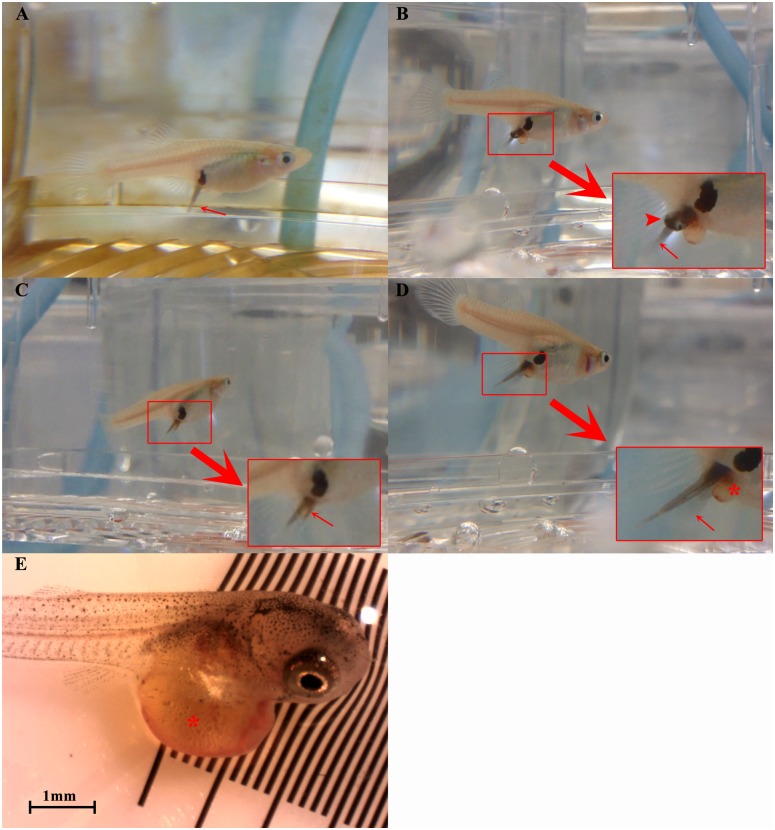
Panel summarizing the parturition process in G. holbrooki.(A) Most frequently observed “tail-first” parturition event where tail of the fry (red arrow) emerged first from the genital pore; (B) Infrequent ‘head-first’ parturition event where the head (arrow head) of a fry emerged first from the genital pore. In this example, note the tail (red arrow) of the next fry born emerged before the one ahead was completely released; (C) On few occasions ‘twin births’ where two fries could be seen emerging simultaneously out of the genital pore (red arrow); (D) Parturition event showing a fry being born with yolk (asterisk) still intact. Note, the free tail (arrow) with head still stuck in the ovarian sac; (E) A safely born fry with the yolk sac (asterisk) still intact. Also see S1 Video.